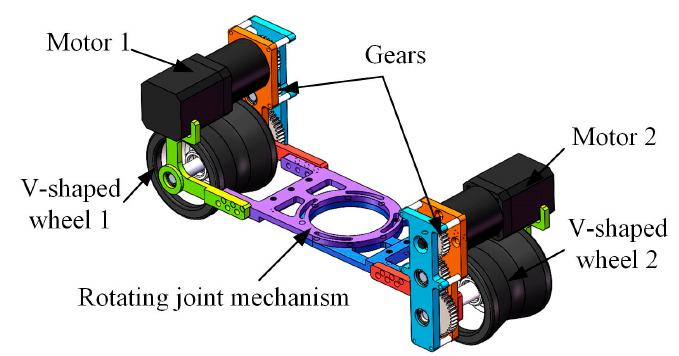
Figure 3. Driving mechanism of the pipeline-climbing robot.